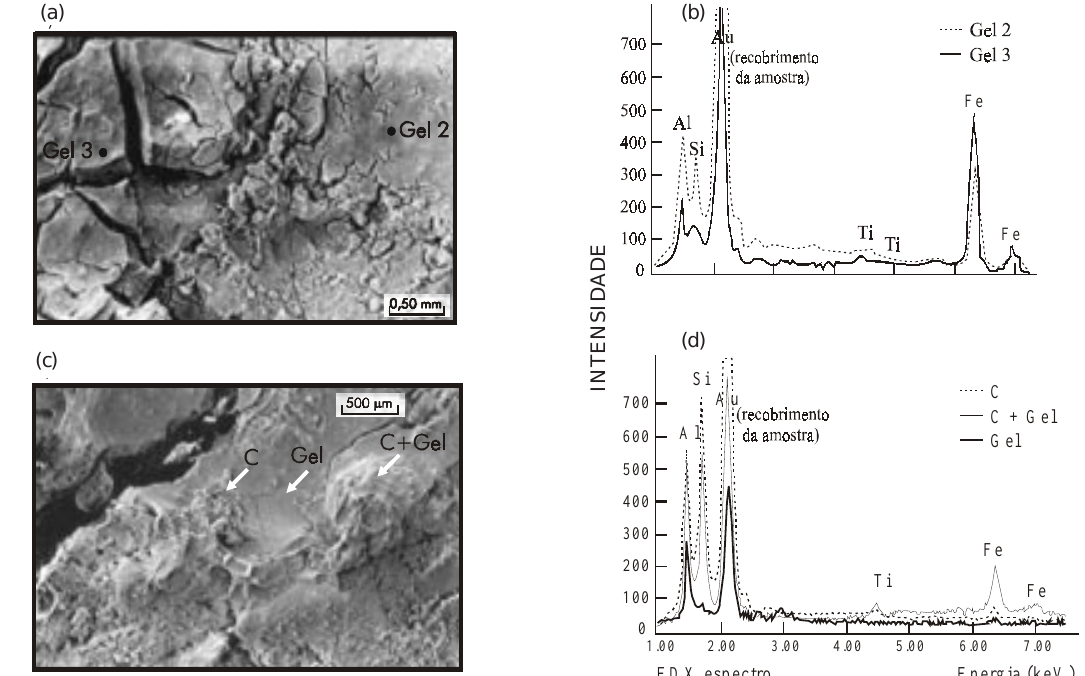
Figura 5. (a) Imagem de ferricutã vermelha ao redor de um poro do duripã amarelo da depressão D2 obtida por Microscópio Eletrônico de Varredura; gel 2: alumino-silico ferruginoso, gel 3: ferro-alumino- silicoso. (b) Espectro da análise semiquantitativa por microssonda correspondente à (a). (c) Imagem do duripã branco da depressão D3 obtida por Microscópio Eletrônico de Varredura. (d) Espectro da análise semiquantitativa por microssonda correspondente à (c).